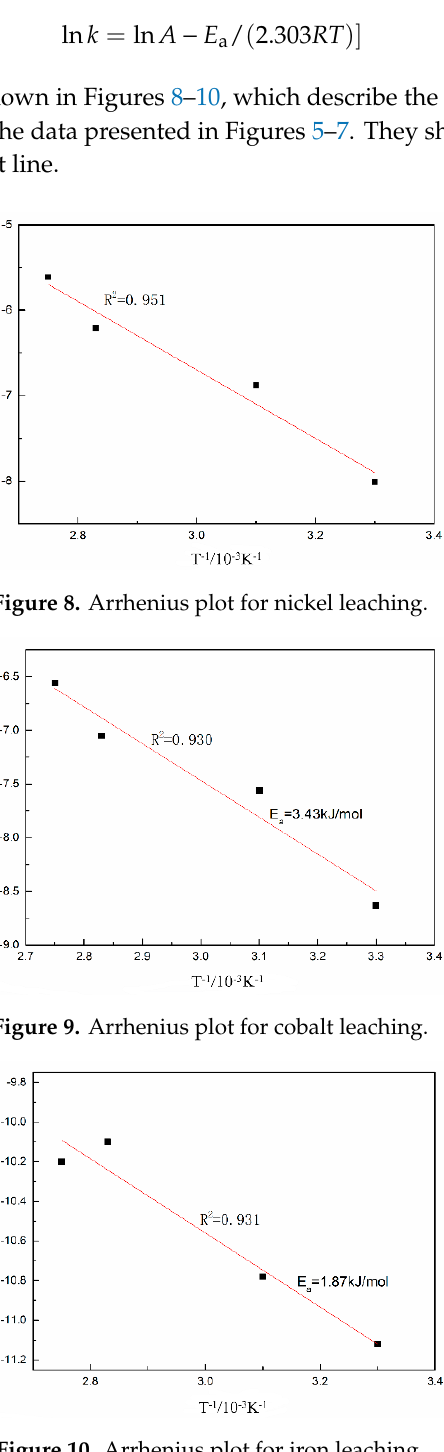
Figure 11. The ln k − ln c(HCl) of Ni, Co, and Fe.